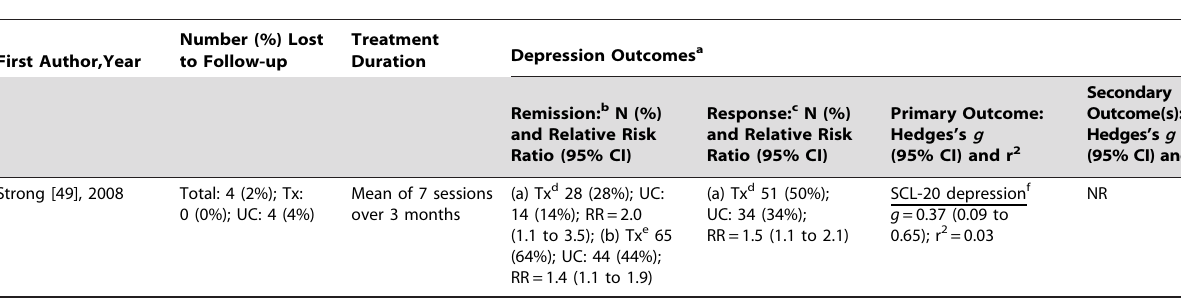
Table 5. Results of Randomized Controlled Trial of Depression Treatment.